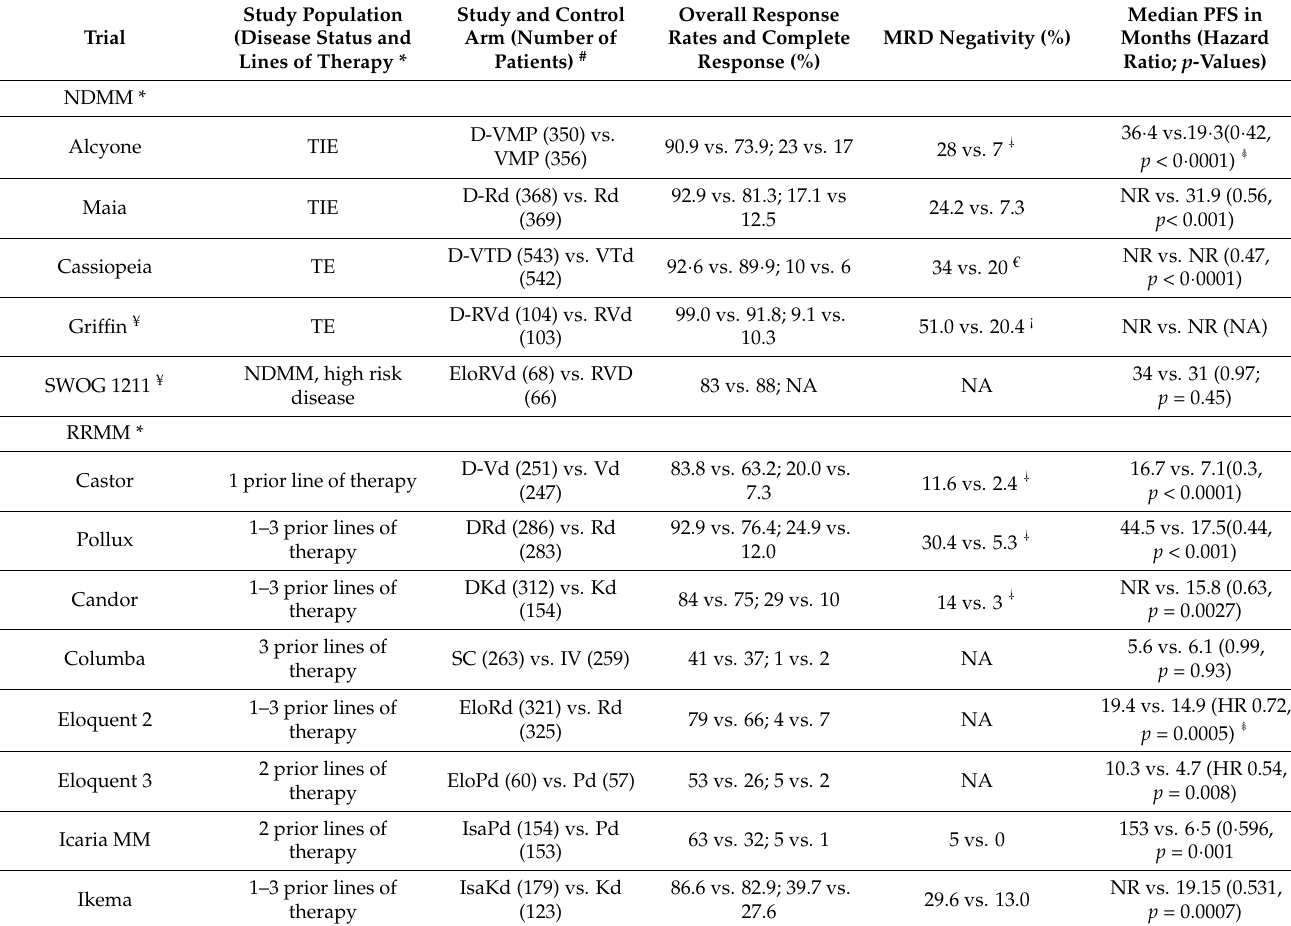
Table 1. Clinical Trials of Monoclonal Antibody in Multiple Myeloma.